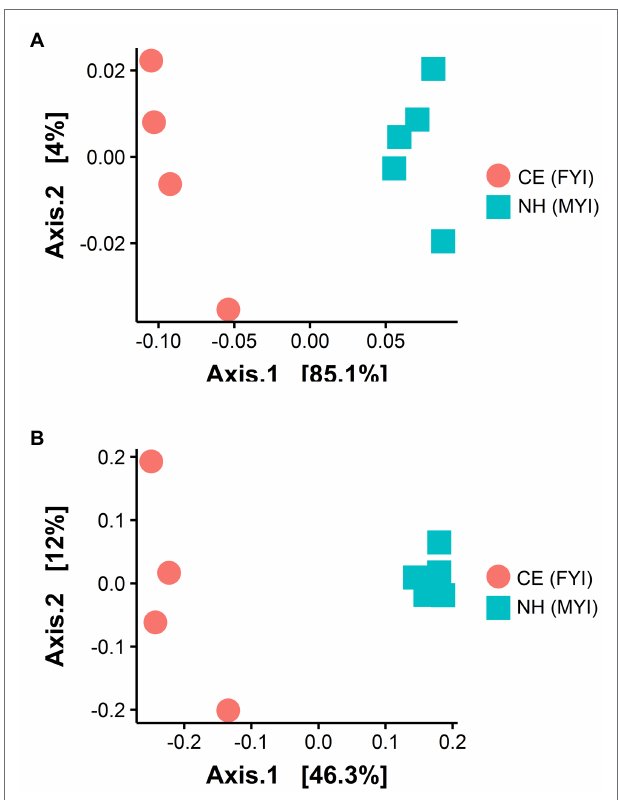
FIGURE 3 | Beta diversity in surface sediment samples from Cape Evans (CE, red circle) and New Harbour (NH, blue square) using weighted UniFrac (analysis of similarity, ANOSIM = 0.9, p < 0.01; (A) and unweighted UniFrac (ANOSIM = 0.9, p < 0.01; (B) dissimilarity